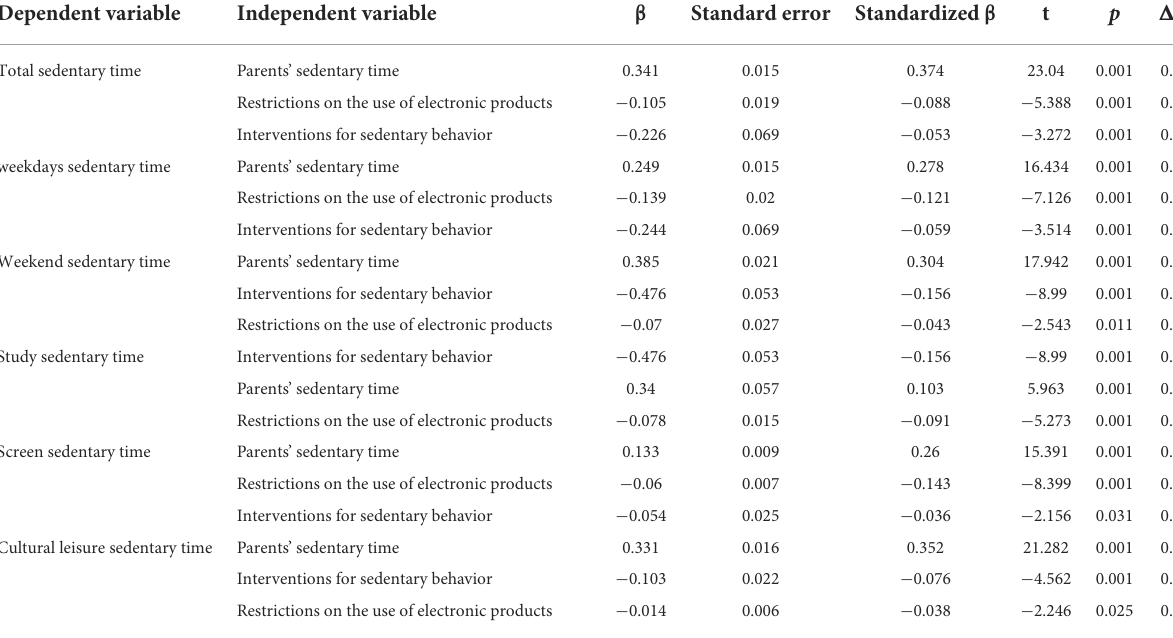
TABLE 11 Regression analysis of sedentary behavior in children and adolescents.